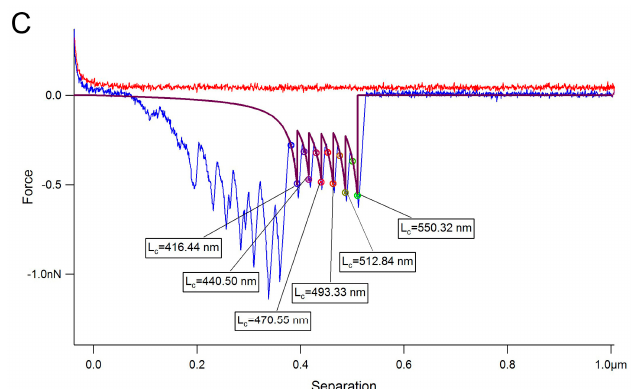
Figure 4. Modelling unfolding of MUB. ( A ) Example force-distance curve of MUB interacting with pPGM; ( B ) Measurement of the contour length ( L c ) in the first set of unfolded domains; and ( C ) Measurement of the contour length ( L c ) in the second set of unfolded domains. Fitting the worm-like-chain (WLC) mathematical model to the negative peaks in the retraction force distance curves ( blue ) enables quantification of the contour and persistence lengths of the unfolding of each domain.